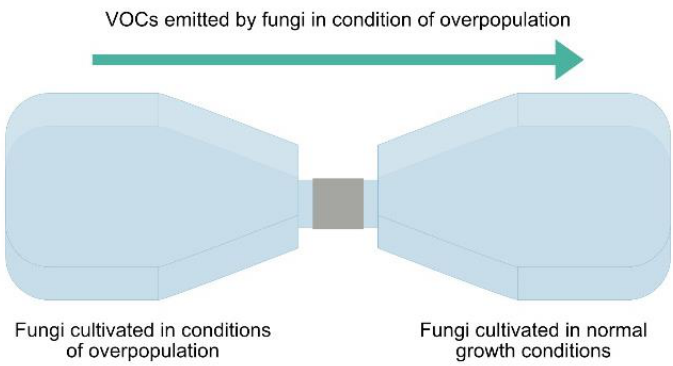
Figure 1. Experimental setup used to observe the effect of the fungal volatolome on fungal growth without physical contact.